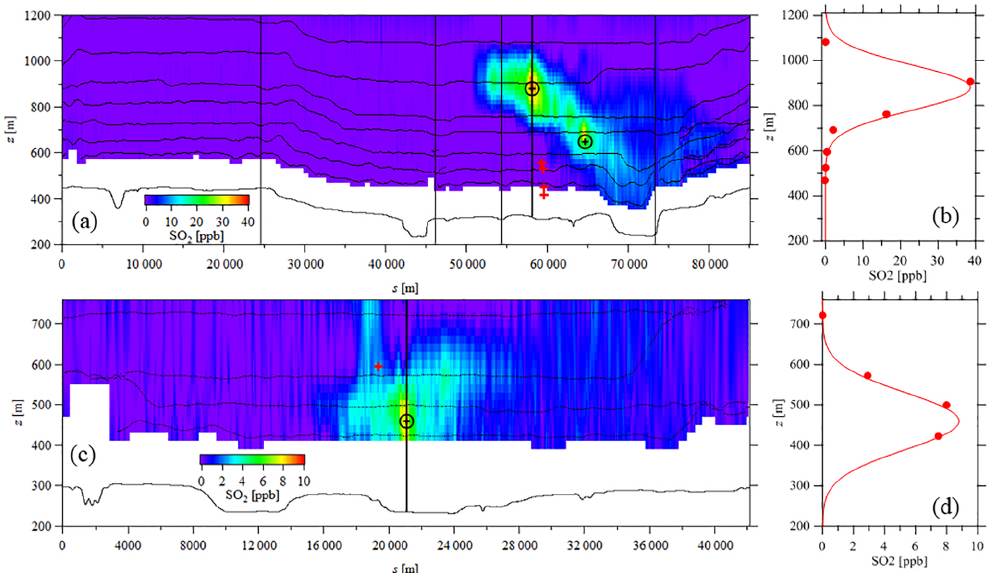
Figure 3. The interpolated images for the box flight (a) and the screen flight (c) (as Fig. 2). The aircraft flight paths are marked by the finely spaced (1Hz) black dots. The surface location ( z surface ) is shown below the flight path. Interpolation is removed between the lowest flight path and the surface, following the TERRA method. In the box (a) , the thin vertical lines show the box corners (see Fig. 2a). The plume locations determined by the Briggs plume rise and the forward trajectories ( s int , z h ) are marked by red plus signs. The plume locations determined by observations ( s p , z p ) are shown as black cross-hairs. The Gaussian fitting used to improve plume height estimation is demonstrated (b, d) for the location marked by the thick vertical black line in each